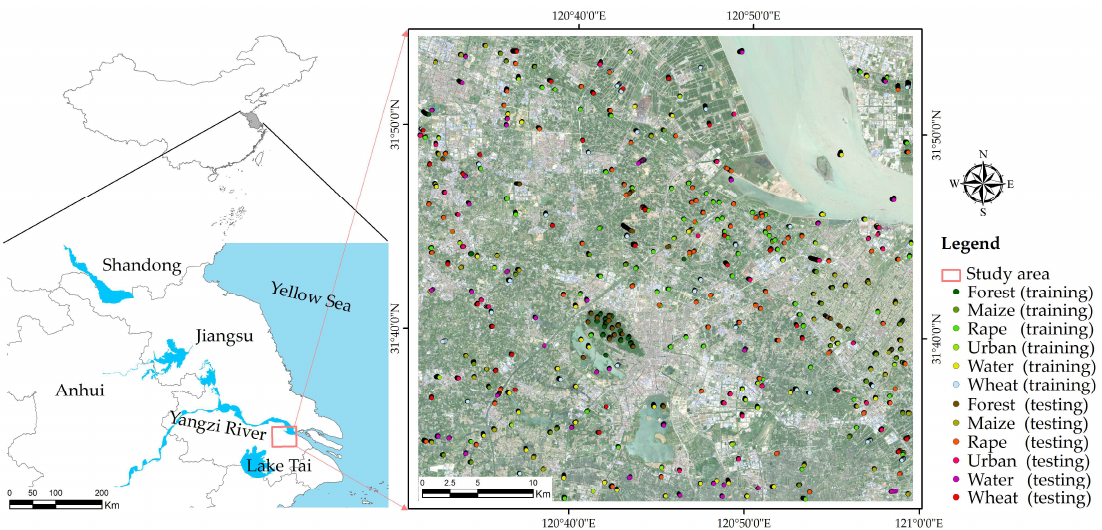
Figure 1. The study area based on the Sentinel-2 multispectral image (Red, Green, Blue). The location of training samples and testing samples is shown in the image. Table 1. Dates (month. day) of winter wheat, rape, and maize phenological stages, as recorded at